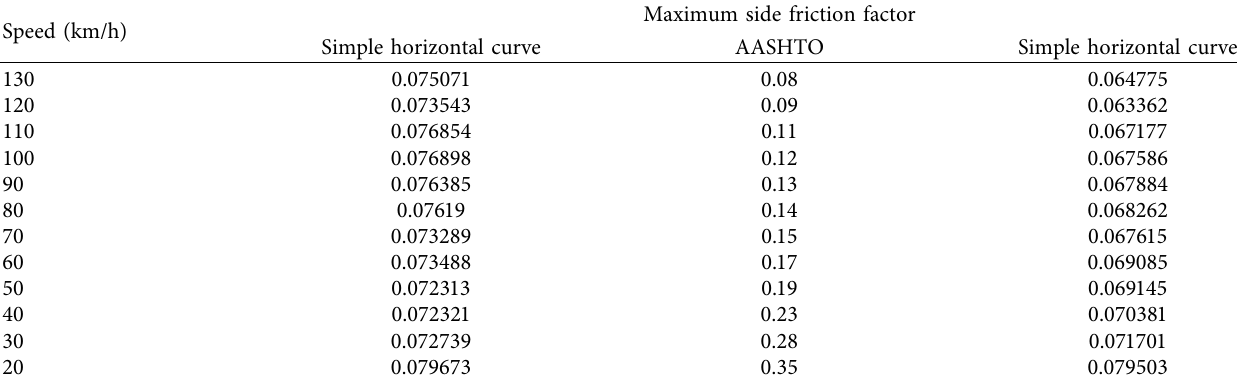
Table 19: Comparison of the maximum side friction factor for SUV between simple and spiral horizontal curves and AASHTO rec- ommended values at a radius of 1